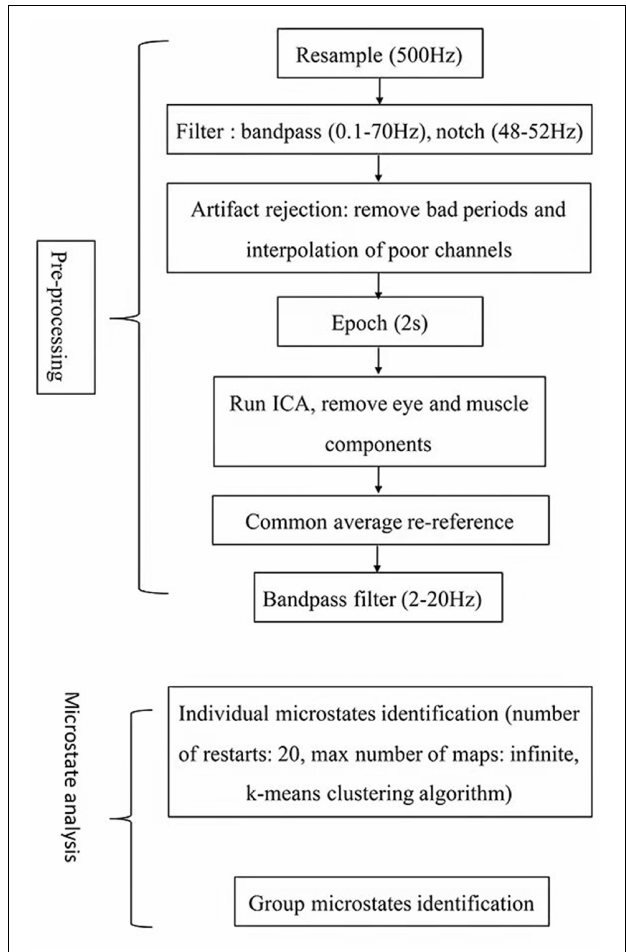
FIGURE 1 | Flowchart detailing the pre-processing and data analysis